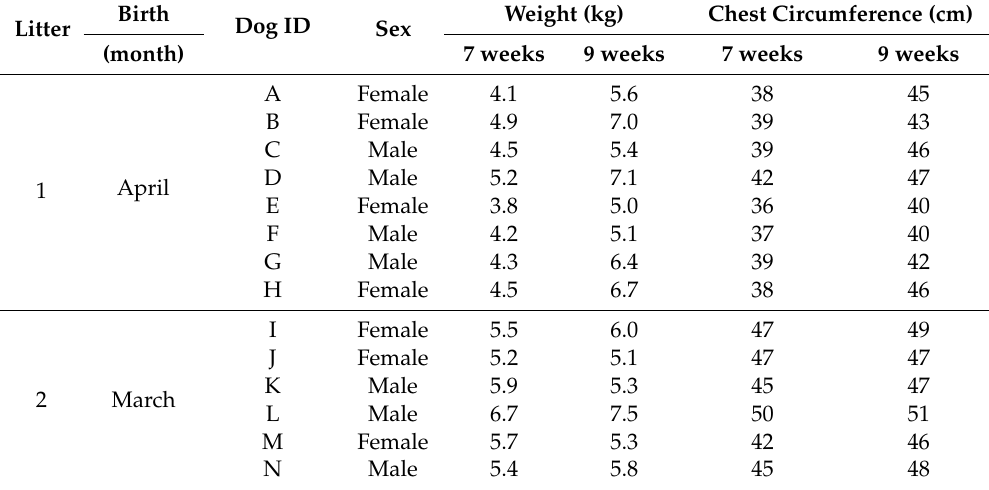
Table 1. Data on the individuals included in our study—14 puppies of German Shepherd Dogs (GSDs) from two litters (A–H puppies are from litter 1, I–N puppies are from litter 2). Birth Weight Dog ID Sex Litter